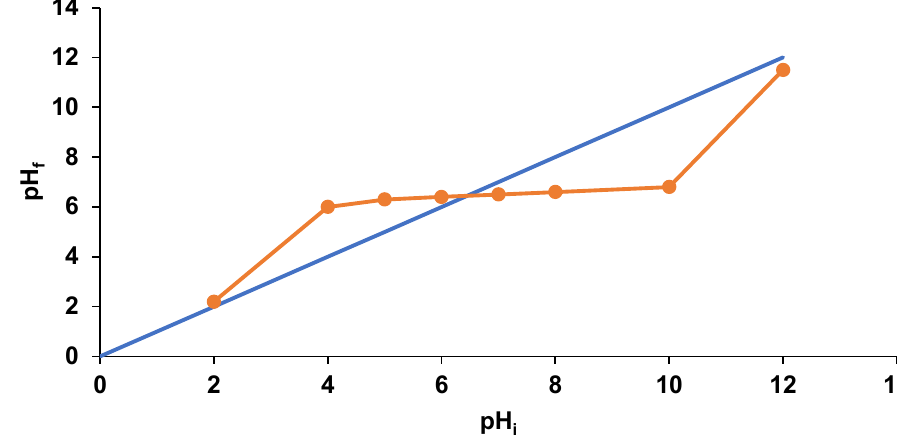
Figure 5. Point of zero charge of the synthesized biosorbent.